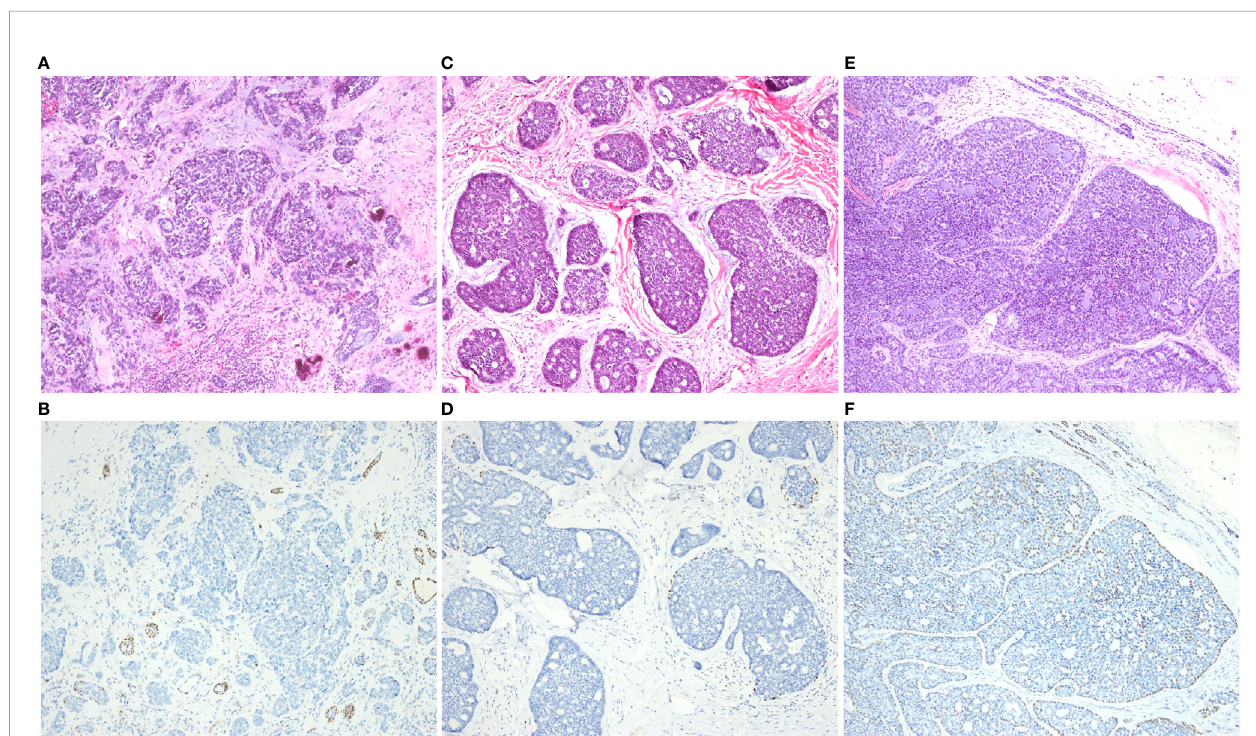
FIGURE 1 | (A) Classic high-grade transformation (HGT) features, including severe nuclear atypia, desmoplastic stroma, and irregular solid nests (100×). (B) Absence of p63 staining in HGT components compared with positive staining in a few cribriform-tubular structures within the same microscope fi eld (100×). (C) Non-classical HGT features include moderate nuclear atypia, myxoid/hyaline matrix, and more regular solid nests (100×). (D) Obvious incomplete p63 staining in a non-classic HGT case (100×). (E) Conventional grade III ACC usually presents as mixed cribriform and solid patterns (100×). (F) The p63 stained basal/ myoepithelial cell layer was still within the mixed architecture of conventional grade III ACC